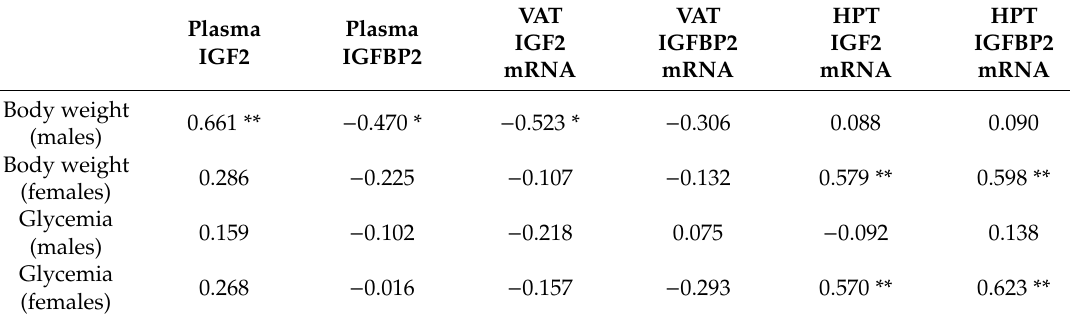
Table 2. Linear correlation between circulating levels of IGF2 and IGFBP2, relative mRNA levels of IGF2 and IGFBP2 in visceral adipose tissue (VAT) and in the hypothalamus with body weight and glycemia in both sexes. * p < 0.05, ** p < 0.01, n =